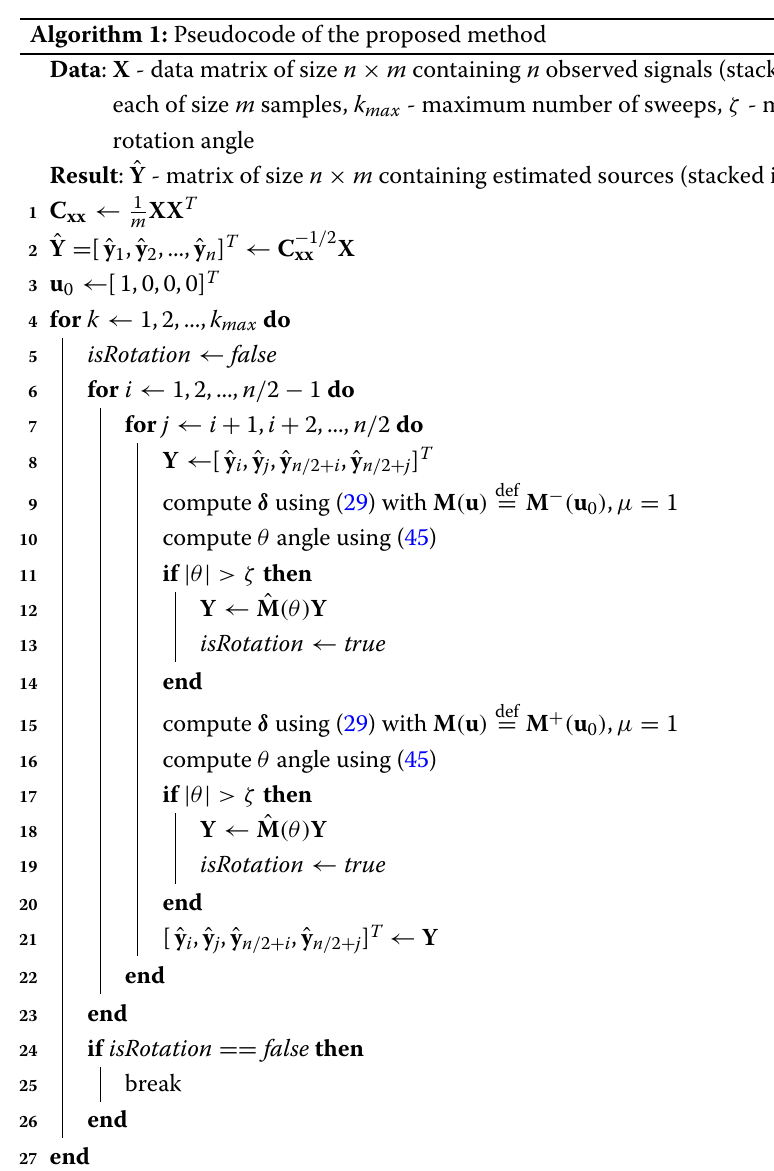
Algorithm 1: Pseudocode of the proposed